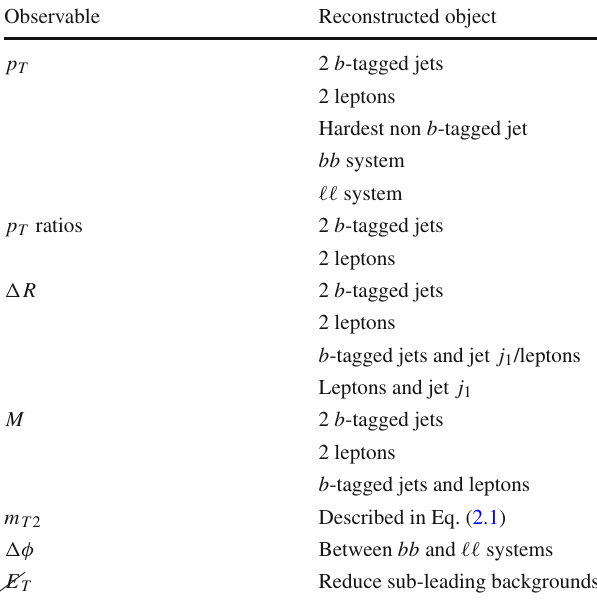
Table 1 Observables included in the boosted decision tree for the lep- tonic τ channels of the pp → hhj analysis of Sect. 2.2 Observable Reconstructed